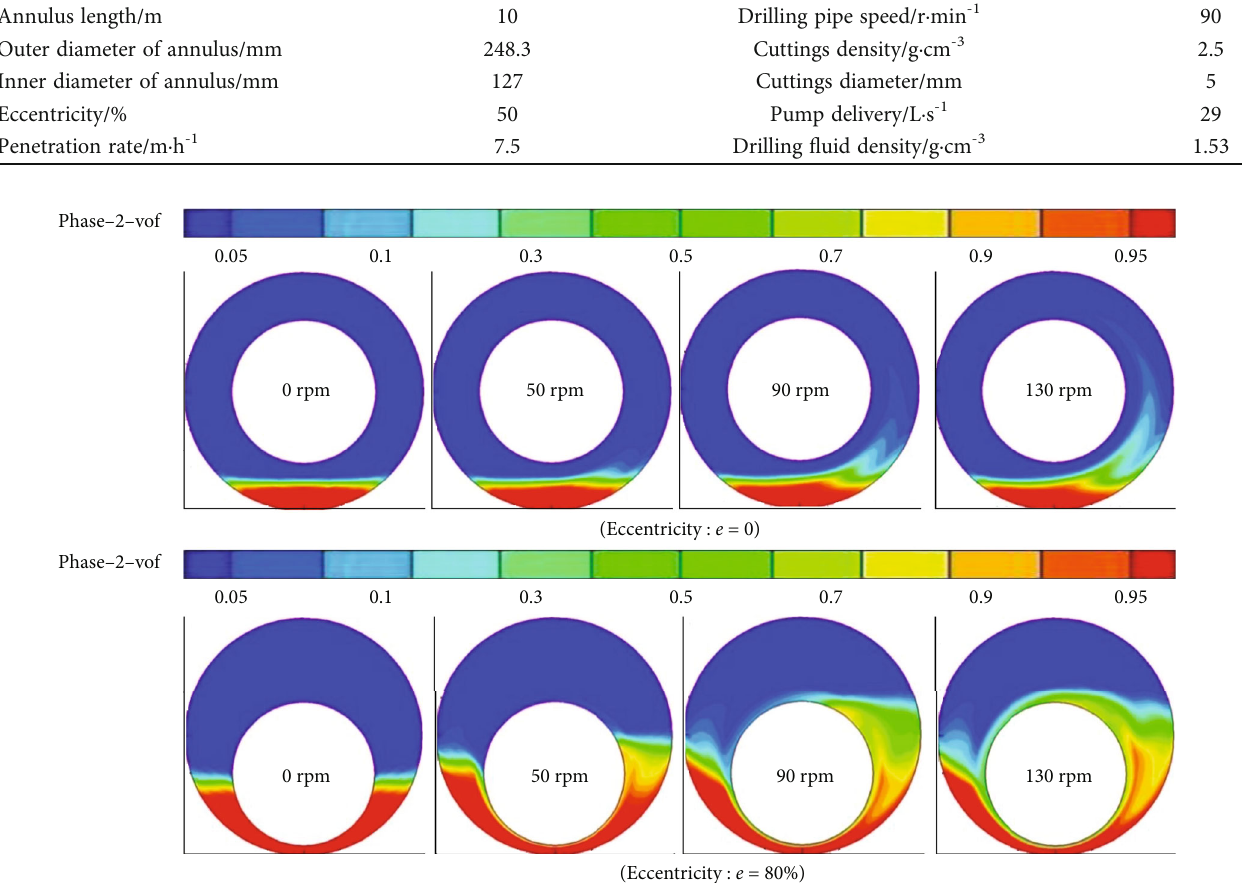
Figure 3: Cloud chart of the cuttings distribution under di ff erent rotational